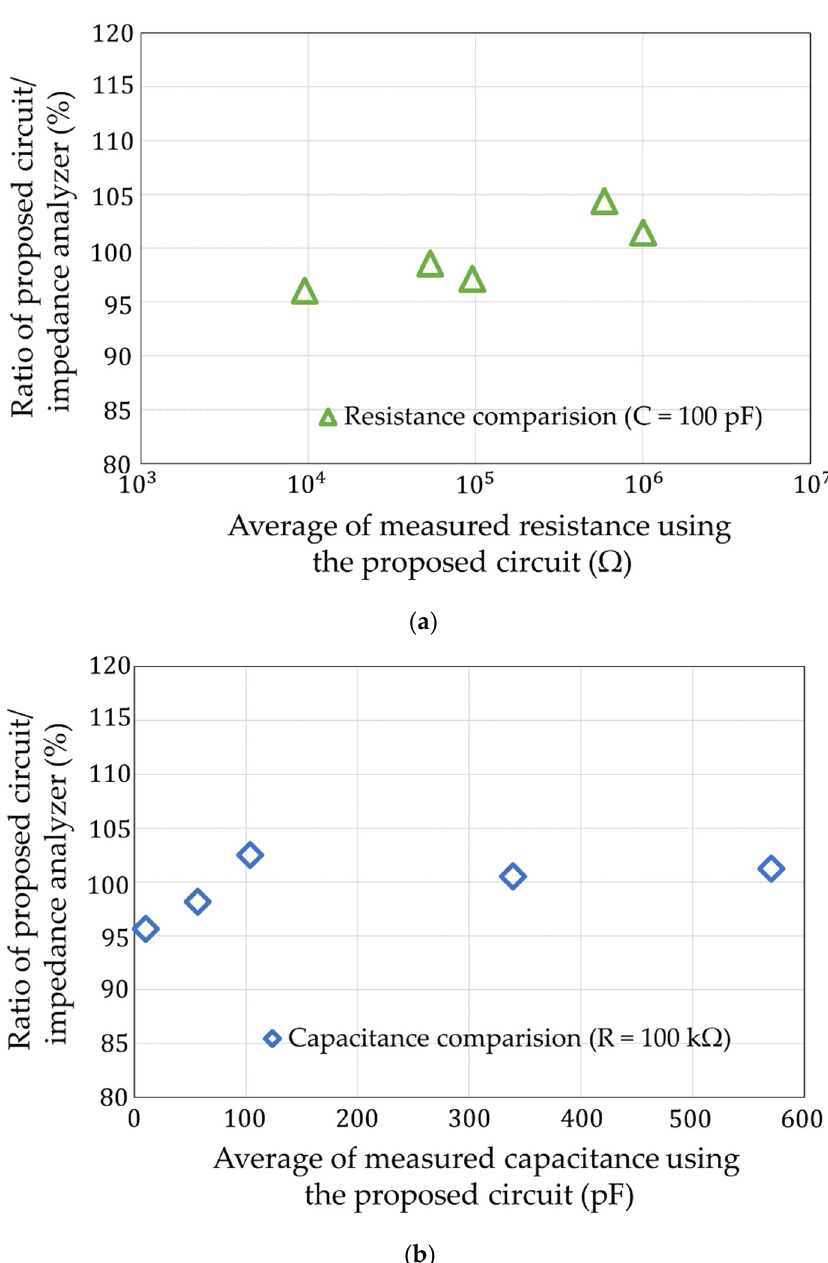
Figure 14. Deviation of the measurements with the impedance analyzer. ( a ) About resistance. ( b ) About capacitance.